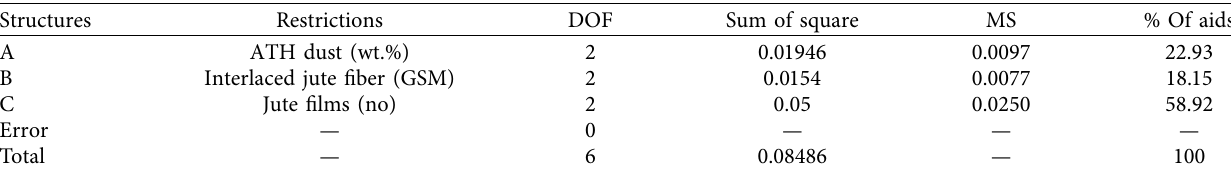
Table 7: ANOVA for grey interpersonal scores.